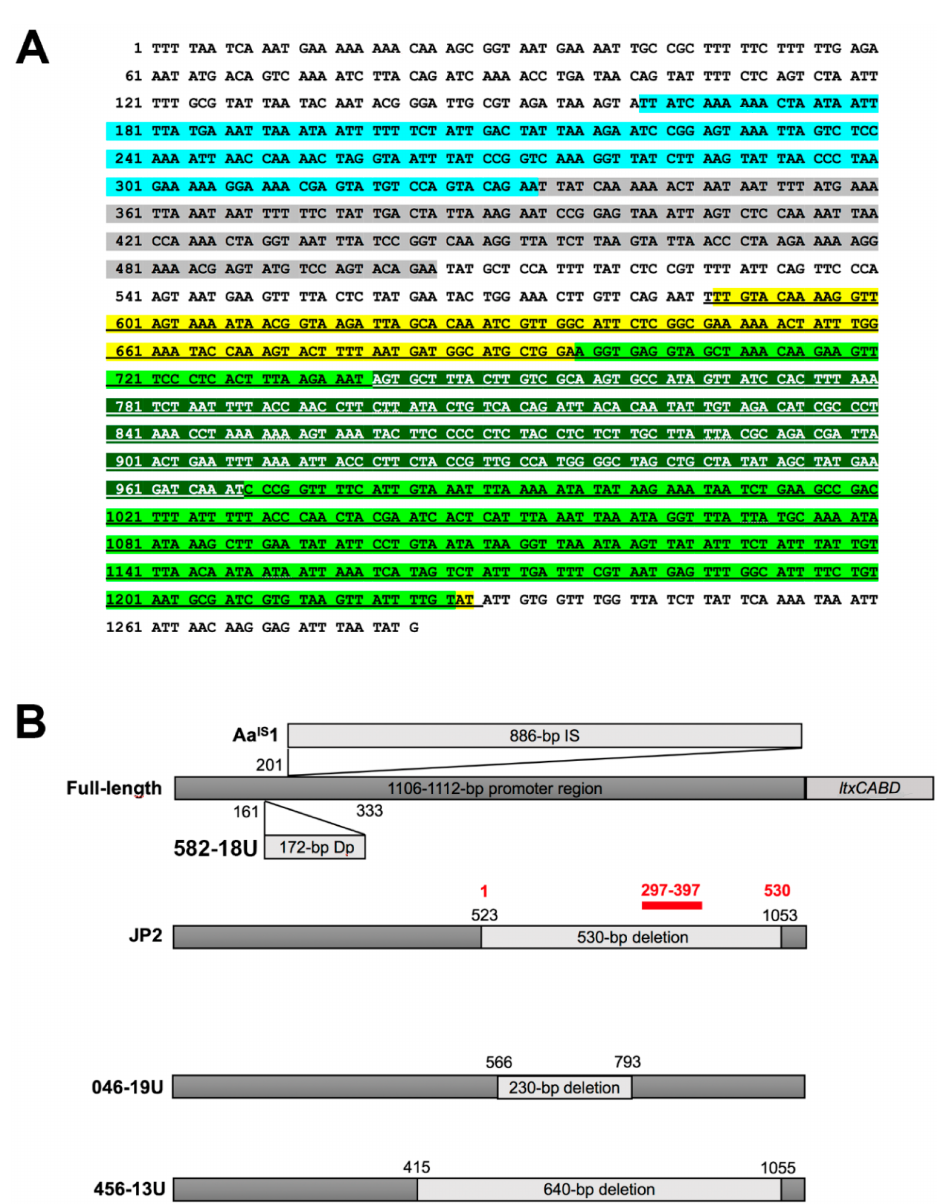
Figure2. Thefivedi ff erent ltxCABD promoterstructuresofthe A.actinomycetemcomitans strainscharacterized in the present study. ( A ) The DNA sequence of the promoter region of A. actinomycetemcomitans 582-18 is shown, which contains 1110 bp—starting from the first nucleotide after the stop codon of the gene glyA and including the start codon of hlyC [41]—and the 172-bp duplication (highlighted in blue and gray). Deletions have been highlighted in the additional indicated colors. The 640-bp deletion of strain 456-13U (bp 415–1055) [26] (underlined and highlighted in yellow), the JP2 genotype 530-bp deletion (bp 523–1053) [41] (light green) and the 230-bp deletion of isolate 046-19 (bp 566–796) (dark green and white letters). ( B ) Schematic illustration of the di ff erent promoter structures, including the one of strain Aa IS 1, containing an 886-bp IS-element [42] and that of 046-19U containing a 172-bp duplication (Dp). The site within the JP2 promoter deletion (bp 297–397) that has been suggested to be bound by a repressor is indicated as a red bar